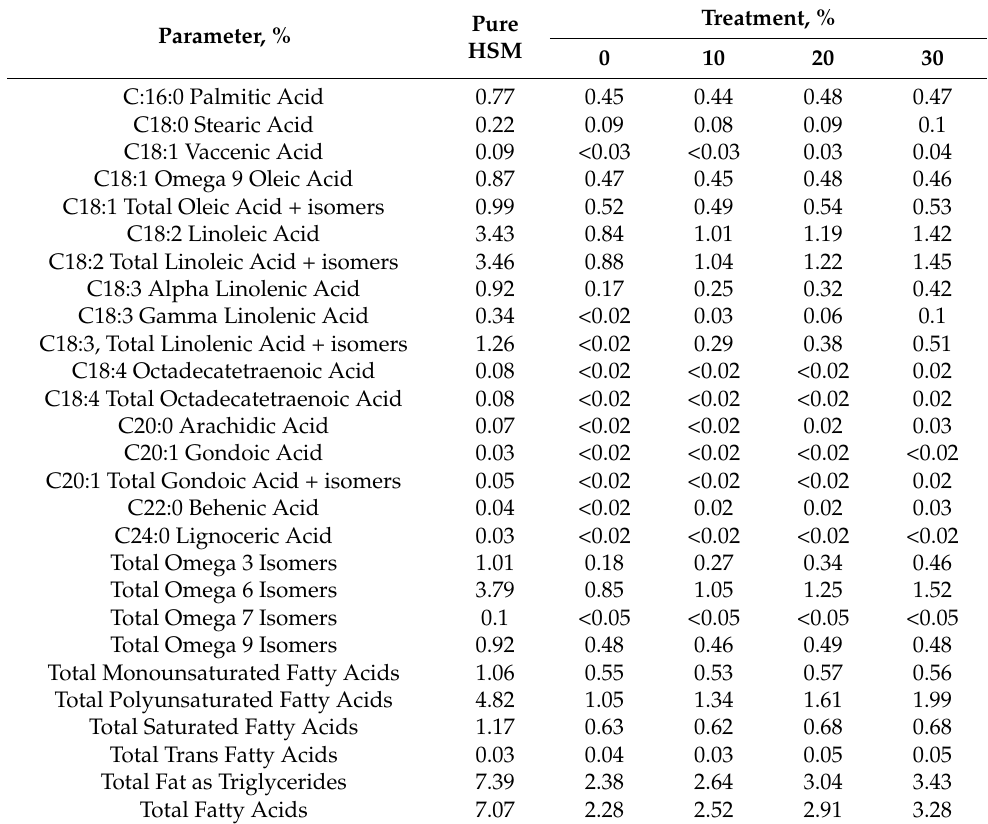
Table 4. Fatty acid composition of respective HSM diets utilized for 60-day feeding trial and pure hemp seed meal utilized in formulating diets.